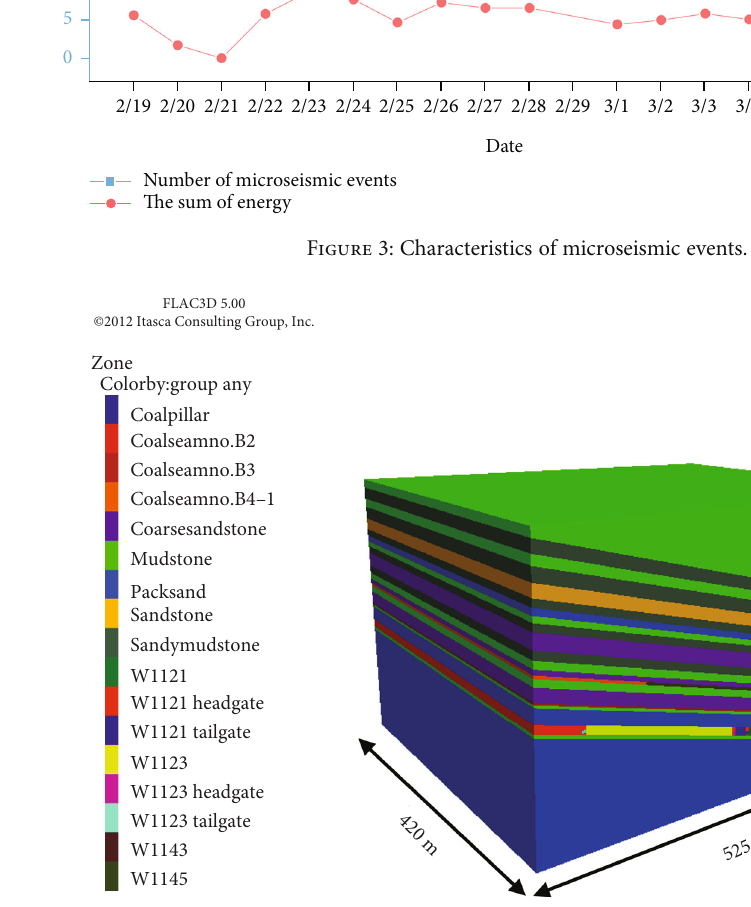
Figure 4: Numerical model indication. Table 1: Results of rock stress